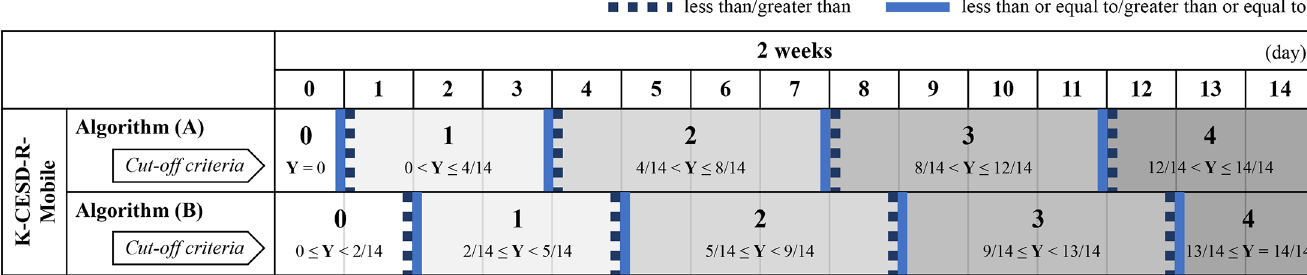
Fig 2. Illustration of response conversion from the binary response format of the mobile K-CESD-R into a 5-point response format. Unlike the standard online K-CESD-R based on a “frequency” approach, the K-CESD-R Mobile app employed two different algorithms based on a “ratio” approach to deal with missing data in prospective daily assessment of depressive symptoms across the 2-week study period. Y = Q/P (Q = total number of times users responded “Yes” to each item; P = total number of days that users completed sessions during the 2-week study period).